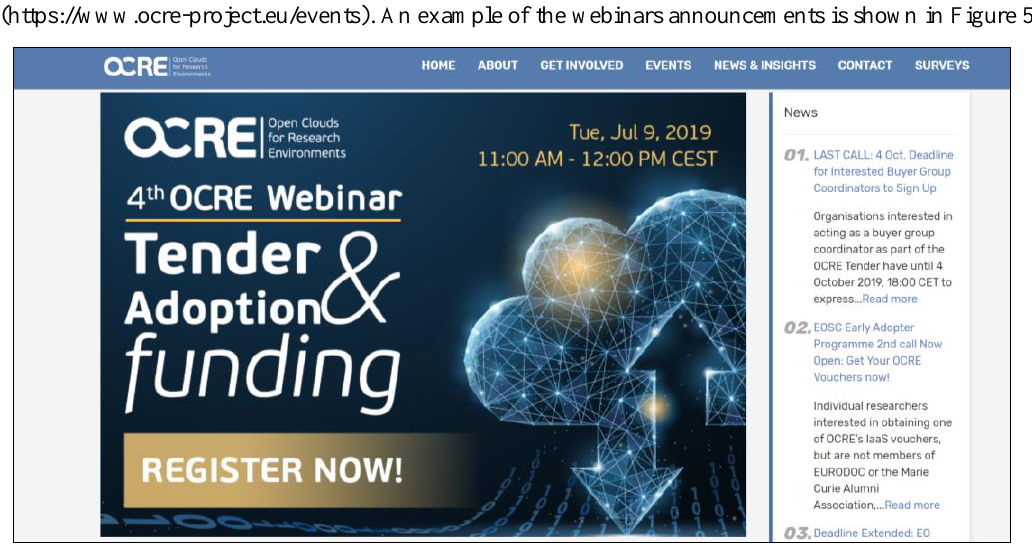
Figure 5. Announcements on the OCRE website regarding the 4th organised